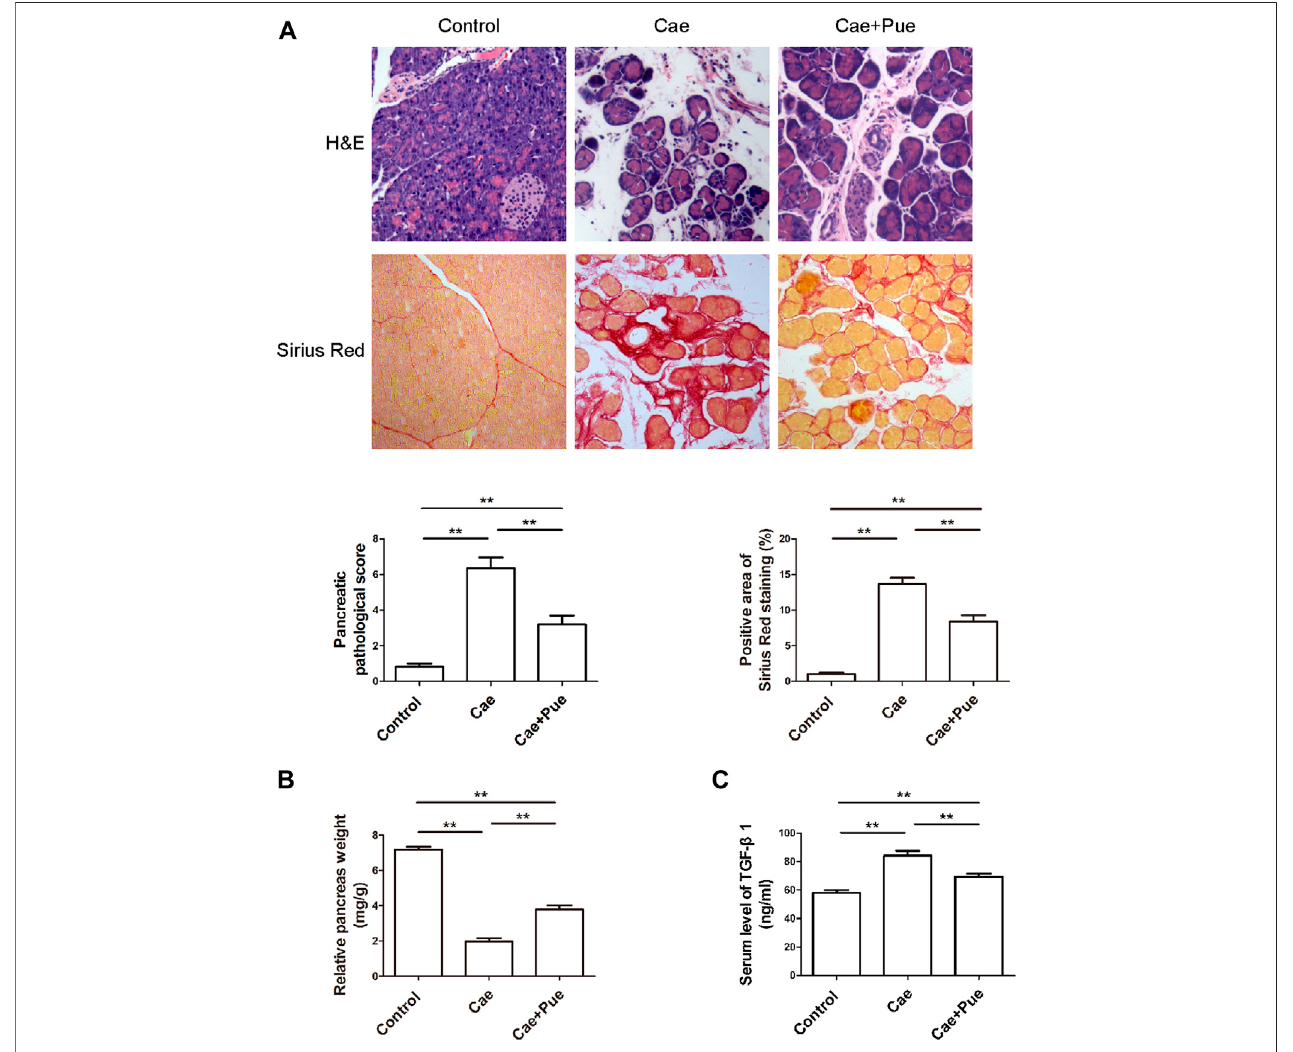
FIGURE 2 | Puerarin ameliorated caerulein-induced pancreatic in fl ammation and fi brosis in vivo . (A) H&E and Sirius Red staining of paraf fi n-embedded pancreatic sections from each group. (B) Relative pancreas weights were calculated and compared among three groups. (C) Serum TGF- β 1 level was measured by ELISA and compared among three